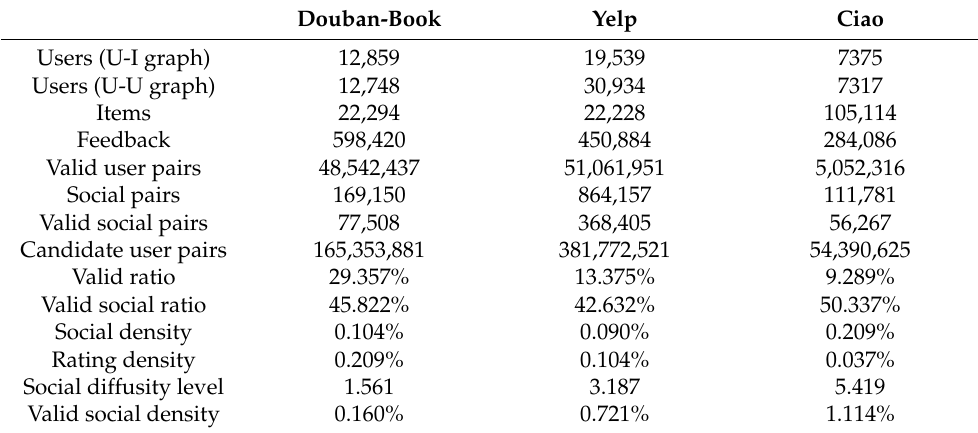
Table 2. Data statistics for social recommendation